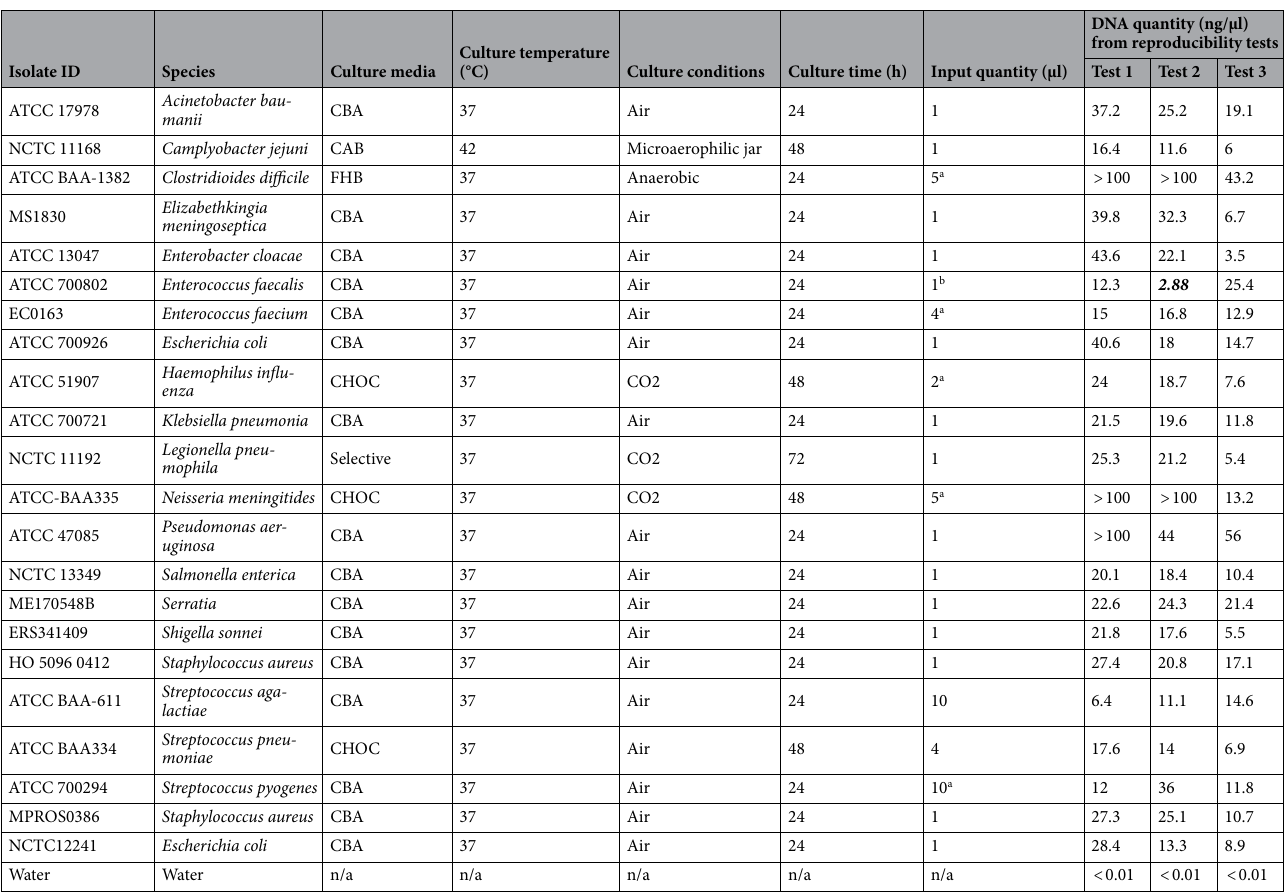
Table 1. Culture conditions and input requirements for 20 bacterial species for the combined DNA extraction protocol. CBA Columbia blood agar, CAB Campylobacter agar base, FHB fastidious anaerobe agar with horse blood, CHOC chocolate agar, Selective Legionella selective medium (all Oxoid, Basingstoke, UK). a The input quantity used for these species is higher than the minimum required to produce sufficient DNA (Supplementary Table 7) to ensure that sufficient DNA was obtained. b 2μl is required for reproducible results. Right hand side shows the DNA quantities obtained from three reproducibility tests performed on different days by different people. Bold italics indicates that insufficient DNA was obtained (< 3.3